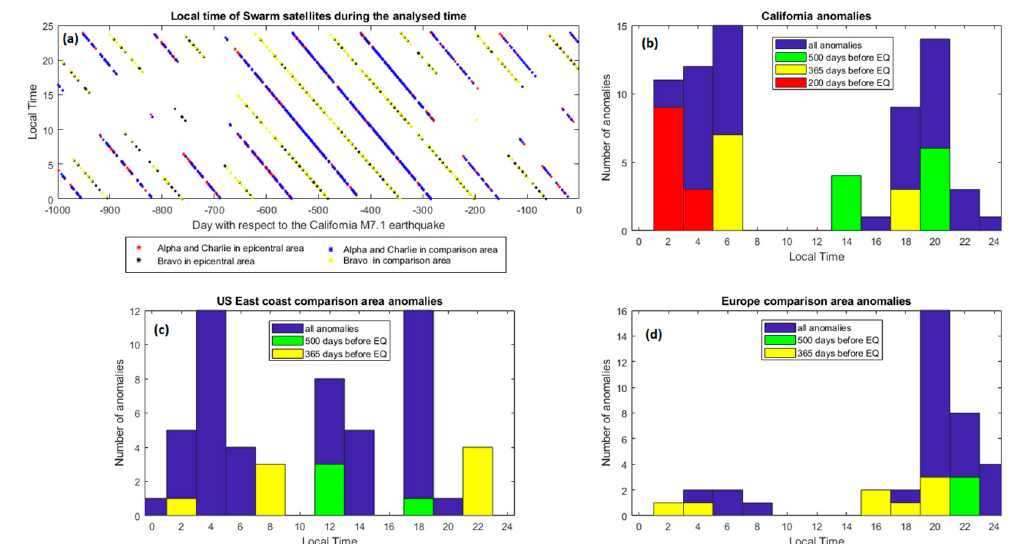
Figure 4. Local time distribution of the analysed windows. ( a ) Passages of the three satellites above the area in geomagnetic field quiet time; ( b ) local time distribution of the anomalies in the earthquake area; ( c , d ) local time distribution of the anomalies in the US East Coast and Europe comparison areas, respectively. The histograms in panels ( b – d ) highlight the anomalies around the jumps indicated by the coloured arrows in Figures 2a and 3a.